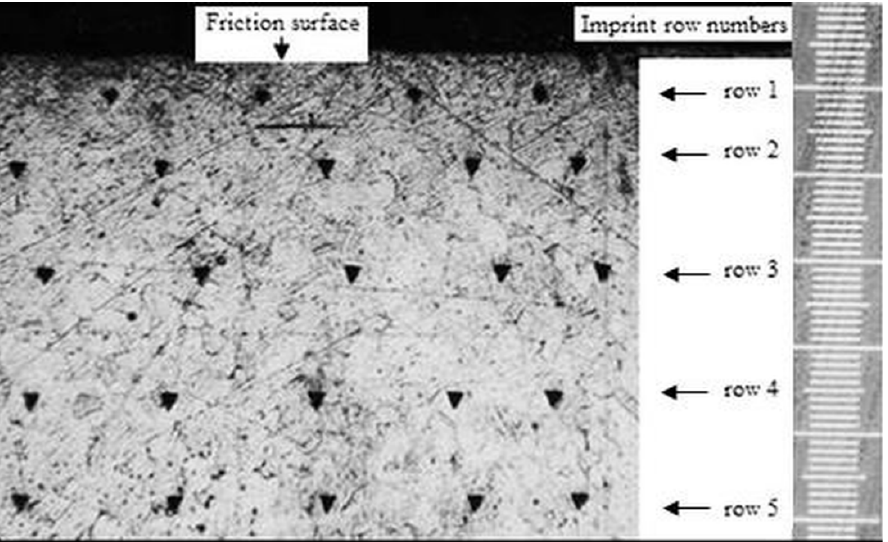
Figure 7. AISI 316L steel. Rows of imprints made on a cross section of sample after friction by the "metal/metal" method. A total of 7 rows have been completed. (A scale division corresponds to a distance of 10